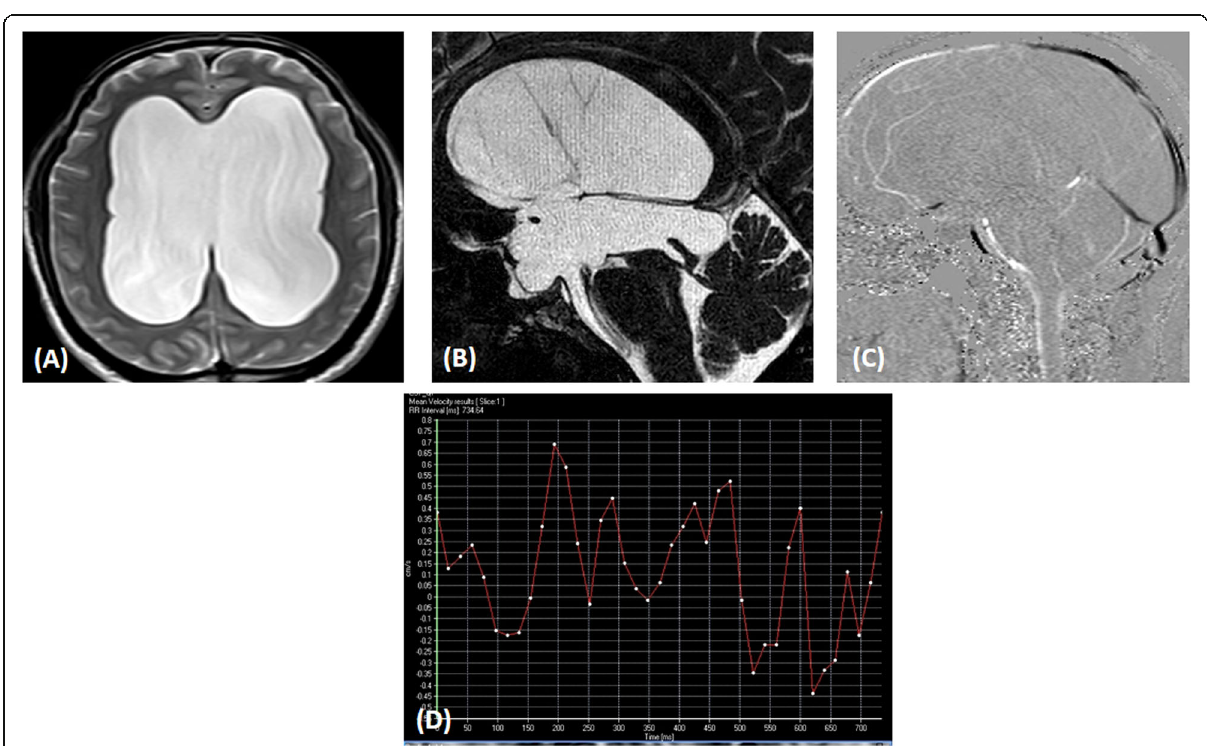
Fig. 4 Male patient aged 46 years old presented with headache axial T2 WI showing hydrocephalus. b 3D DRIVE image showing aqueductal web. c Sagittal phase image in systole showing no CSF flow in the aqueduct. d Velocity time curve showing markedly irregular CSF flow curve indicating irregular to and fro movement of the CSF proximal to the site of obstruction. Diagnosis is obstructive hydrocephalus caused